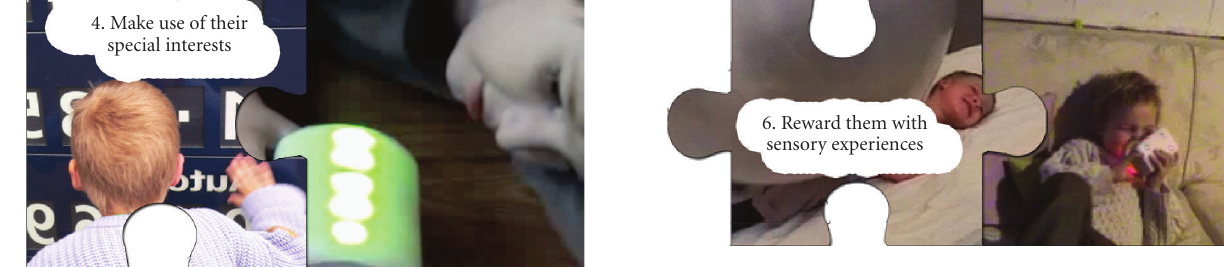
Figure 10: Sensory experiences: (a) Beer gets rewarded with deep pressure during speech therapy. The speech therapist rolls the ball roughly over his body. This makes him feel relaxed and happy. (b) Beer playing with LINKX; he likes to look at the coloured lights from very close and laughs out